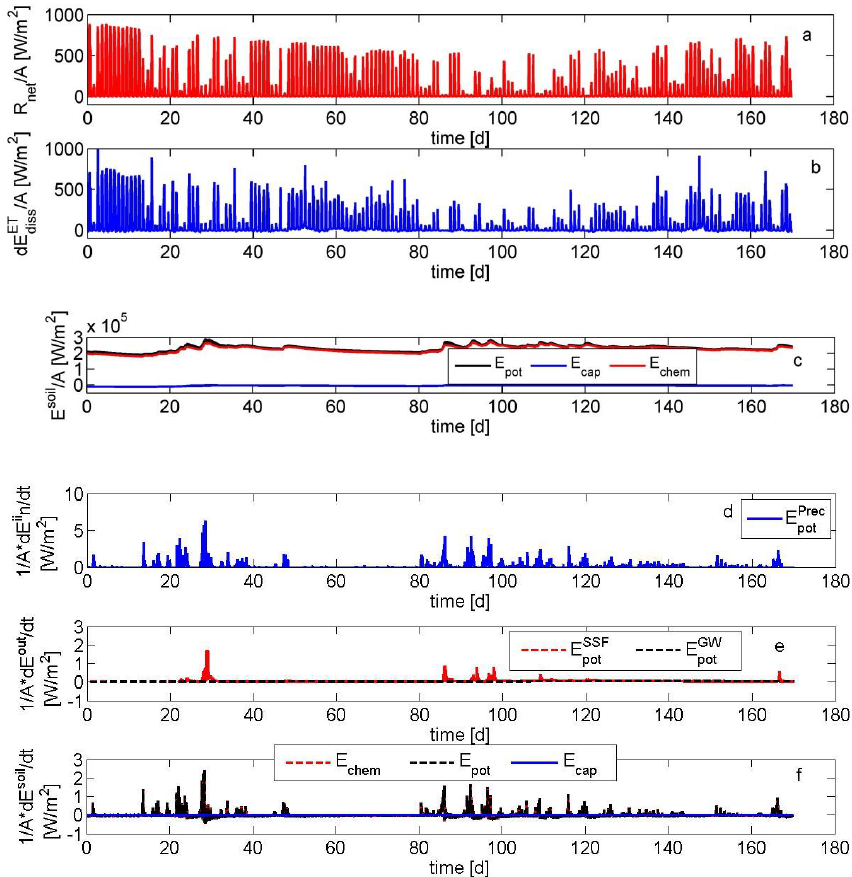
Fig. 11. Free energy balance components as functions of time for numerical experiment 3 in the Malalcahuello headwater. Observed global radiation input (a) and simulated latent heat flux λ ET (b) as function of time. Trajectories of capillary binding energy, potential energy and free energy of soil water (c) (derived from Eq. 2). Potential energy input by rainfall (d) , potential energy export by means of subsurface storm flow groundwater recharge (e) , as well as change rates in free energy, capillary binding energy and potential energy of soil water (f, compare Eq. 7). Note that the curves in panel f are the numerical temporal derivatives of the curves in panel c).